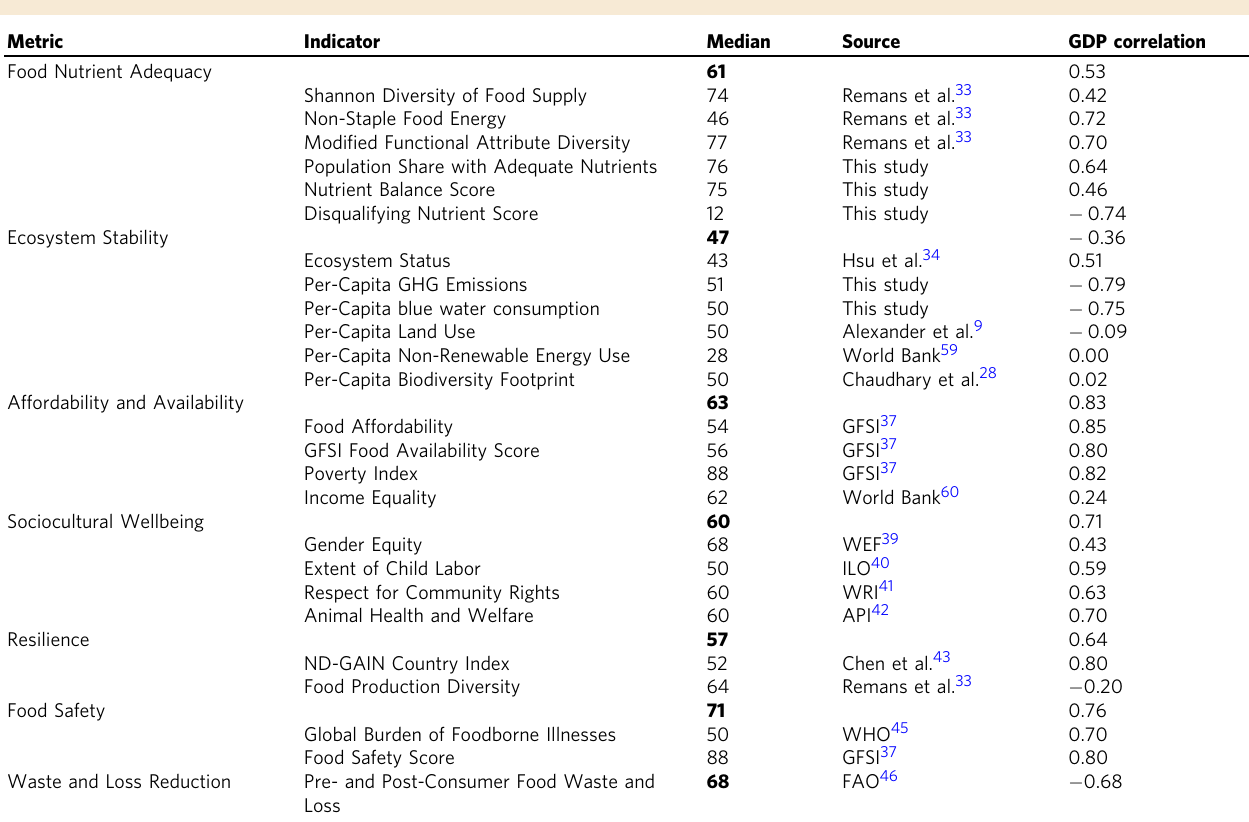
Table 1 Seven food system metrics, their indicators, and data sources